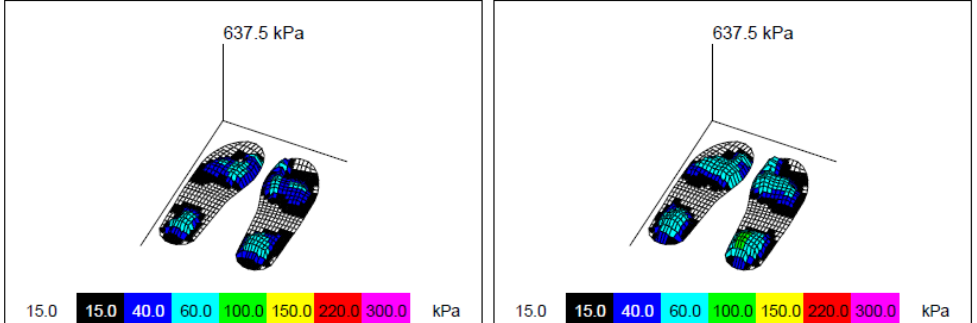
Figure 3. Three-dimensional plantar pressure mapping for test–retest results of participant 008. Obtained from Novel Multiprojects-e (v 24.3.34, Novel, Munich, Germany).